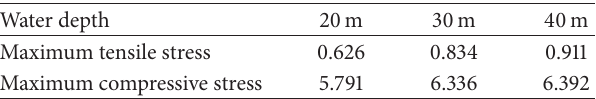
Table 2: Maximum principal stress under different water